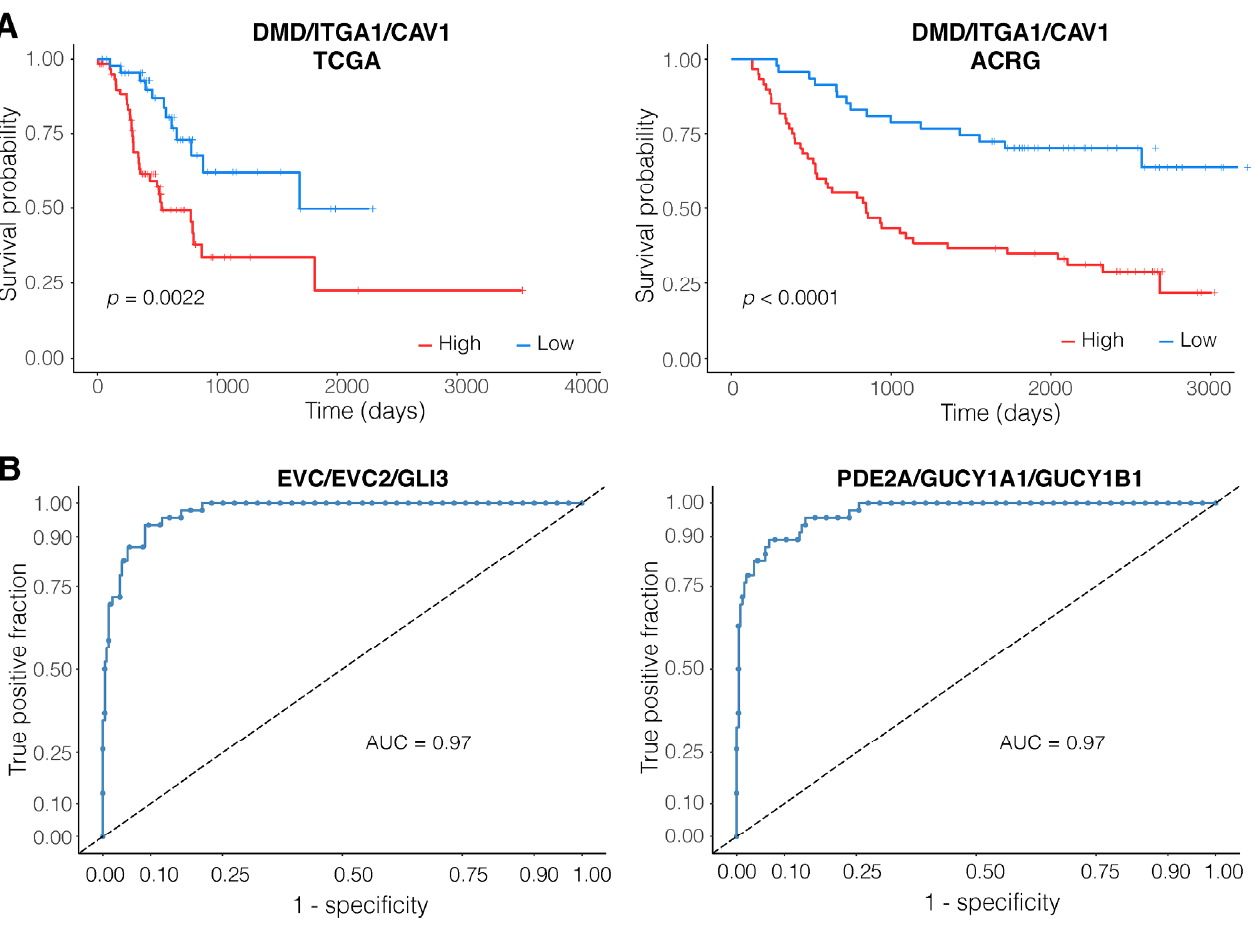
Figure 2. Diagnostic and prognostic capacities of the identi fi ed top motifs and members of the miRNA-based diagnostic model. ( A ) DMD/ITGA1/CAV1 was identi fi ed as the top motif with consistent relevance to prognosis in both TCGA (left) and ACRG (right) cohorts (hazard ratio > 3 in both cohorts); ( B ) Receiver Operating Characteristic (ROC) curves of the top motifs with diagnostic relevance in the validation set (ACRG cohort). For the complete set of plots for TCGA survival analysis, ACRG survival analysis, and ROC curves, refer to Supplementary Figures S4–S6.